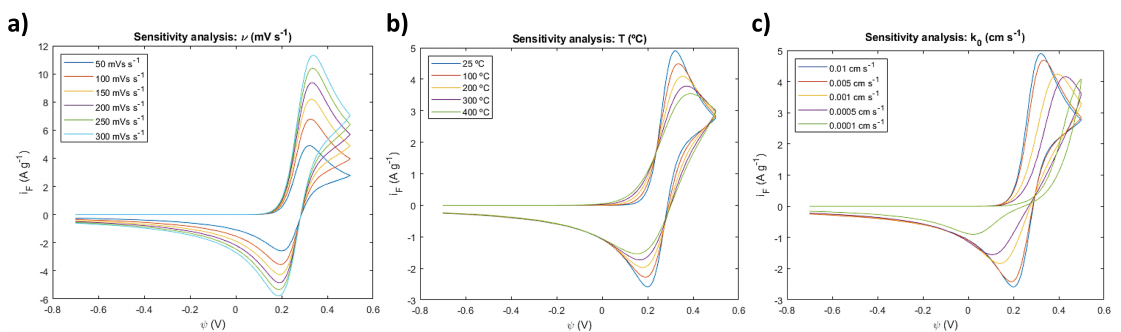
Figure 3. 1. Figure 6. Sensitivity analysts of CV simulation for ( a ) scan rate, ( b ) temperature, and ( c ) reaction rate